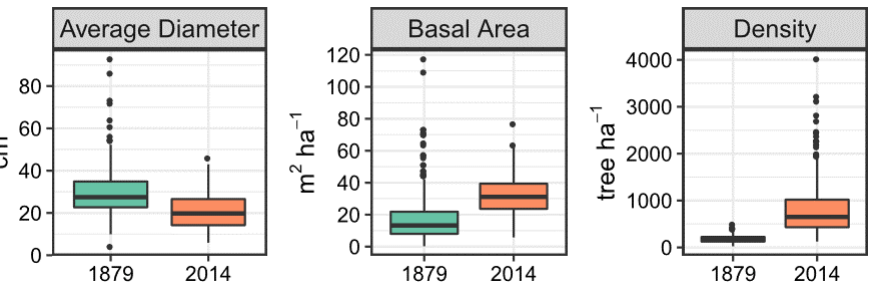
Figure 3. Historical and contemporary forest structure. Box plots depicting average tree diameter, stand basal area, and tree density historical (1879) and contemporary (2014) forest conditions. Comparisons between the two time periods indicate a decrease in average tree diameter, an increase in basal area, and a drastic increase in density from historical to contemporary periods.